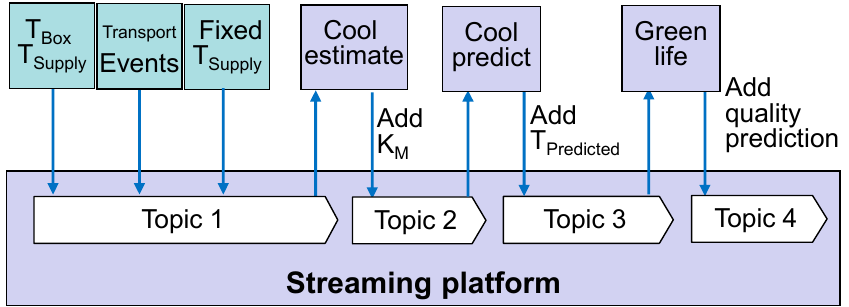
Figure 5. Enriched data stream consisting of successive topics with additional information.